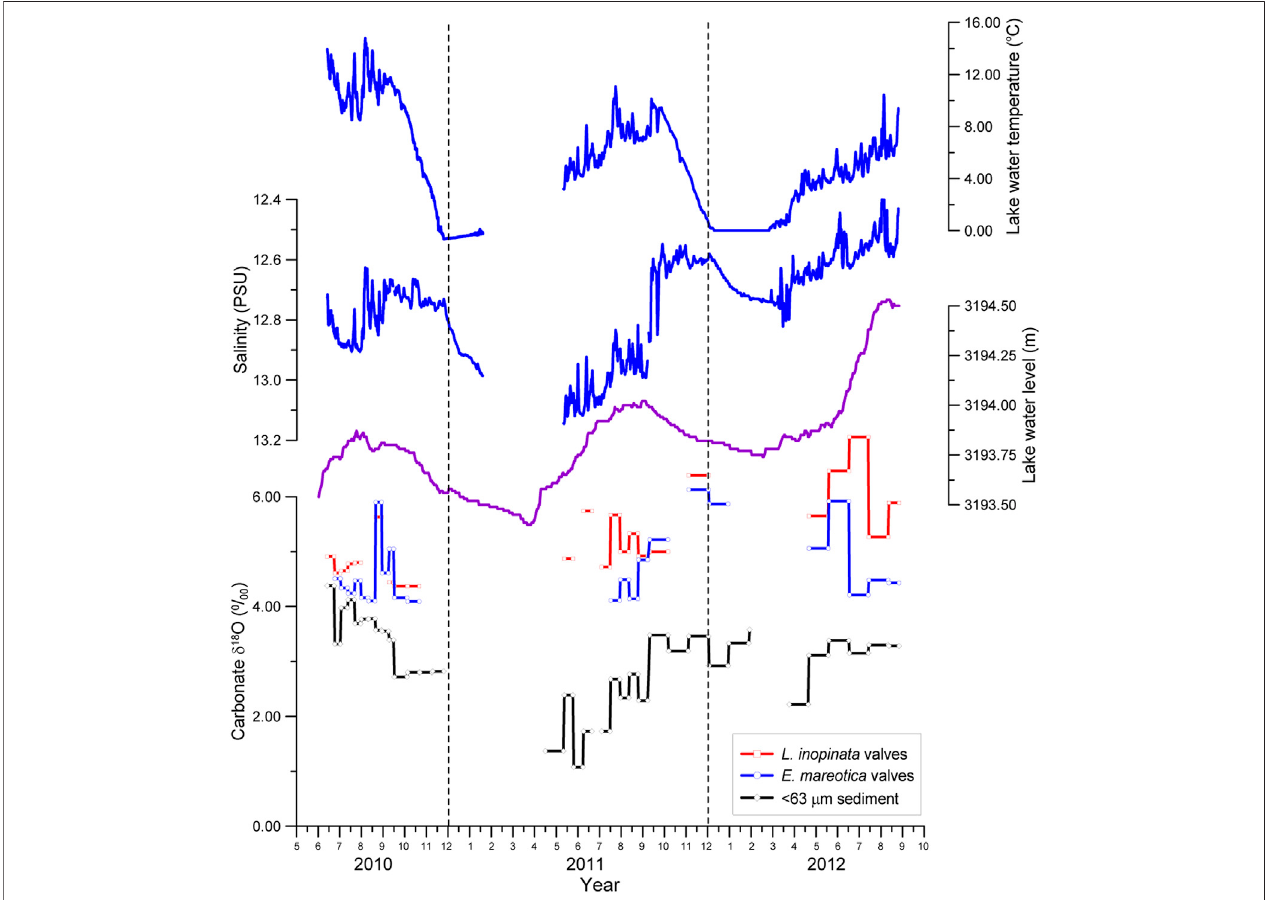
FIGURE4| Seasonalandinterannualvariationsin δ 18 Oratiosfortwospeciesofadultostracodshells( L.inopinata and E.mareotica )andcarbonatesofthe < 63 μ m fraction in sediment from July 2010 to September 2012, along with water temperature, salinity, and water level of Lake Qinghai.